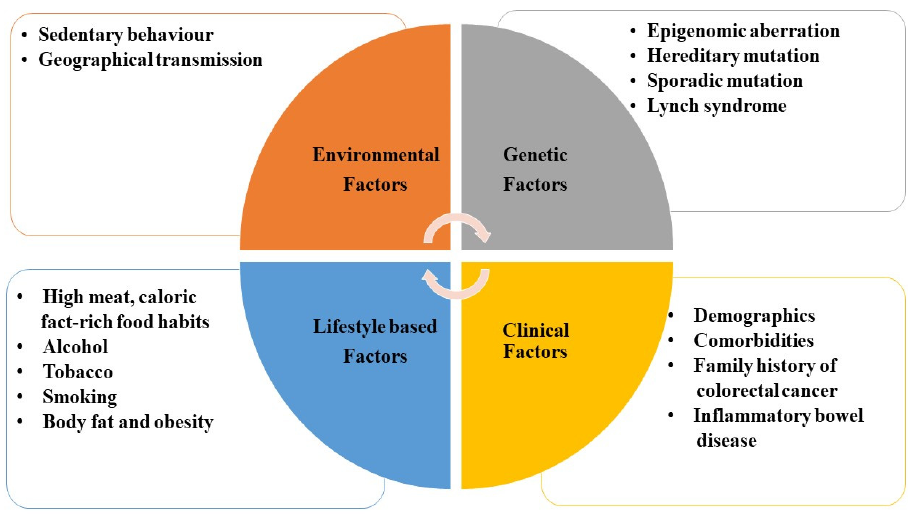
Figure 1. Schematic diagram representing a few of the risk factors associated with CRC.